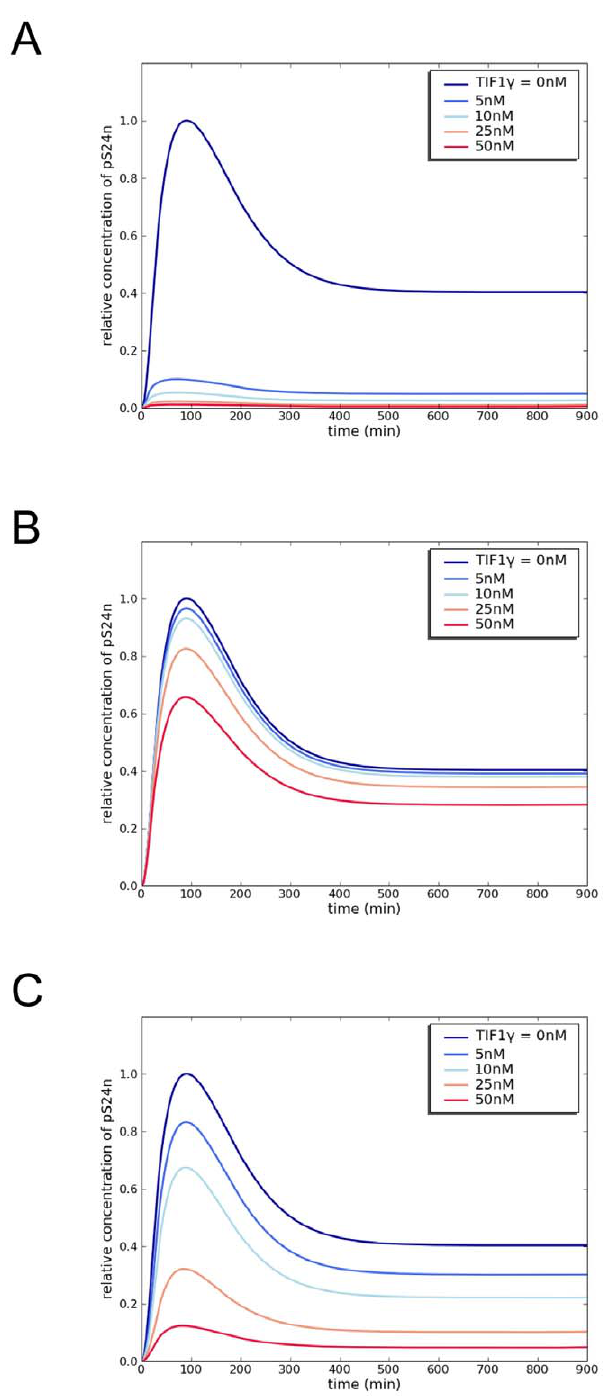
Figure 2. Effect of TIF1 c on TGF- b signaling. Modeling analysis of the pS24n response to increasing TIF1 c concentrations at a 10 nM TGF- b input. A) Model according to [4]; B) model according to [7] and C) integrated model.